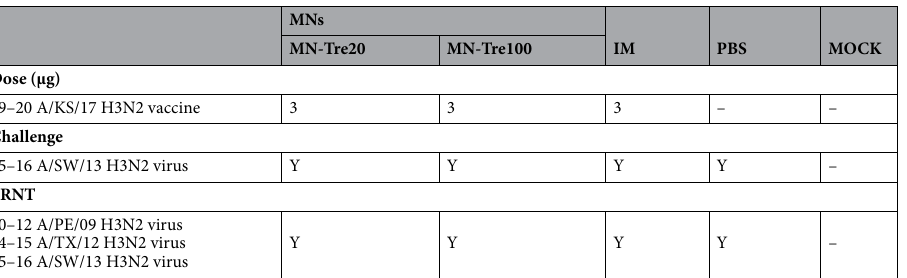
Table 3. Information on challenge test using 19–20 A/KS/17 H3N2 microneedle vaccines against different- year H3N2 viruses using the measurements of body weight change, survival rate, and PRNT test. MNs microneedles, IM intramuscular administration, PRNT plaque reduction neutralization